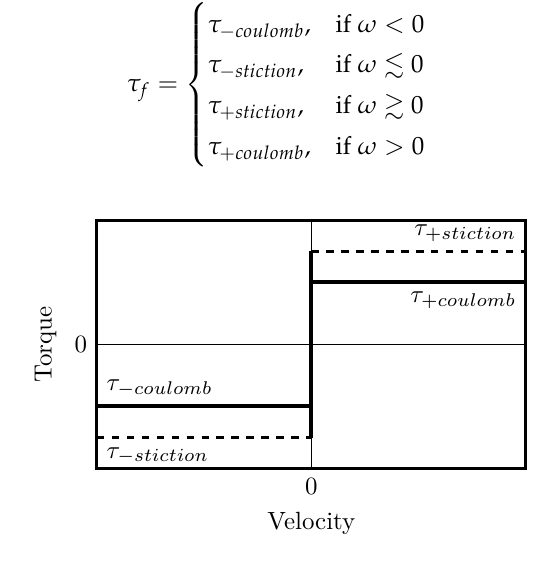
Figure 13. Friction